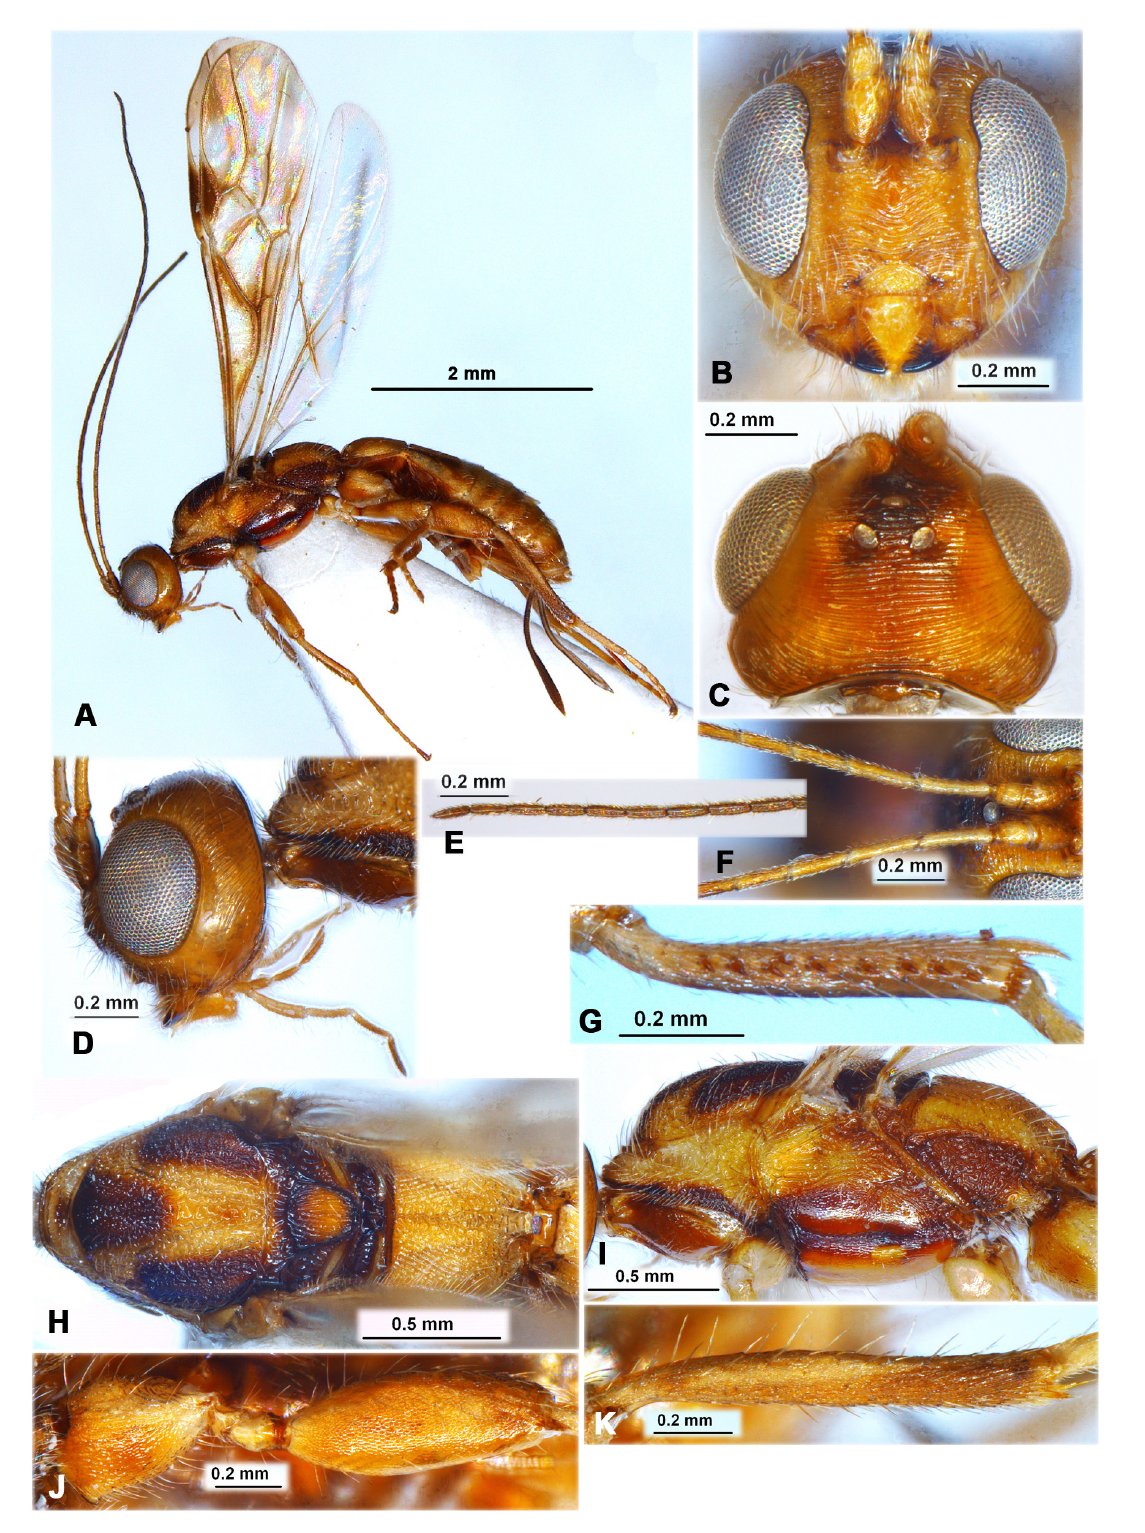
Fig. 7. Doryctes ( Neodoryctes ) arrujumi Belokobylskij sp. nov., holotype, ♀ (RMNH). A . Habitus, lateral view. B . Head, front view. C . Head, dorsal view. D . Head, lateral view. E . Apical segments of antenna. F . Basal segments of antenna. G . Fore tibia. H . Mesosoma, dorsal view. I . Mesosoma, lateral view. J . Hind coxa and femur. K . Hind